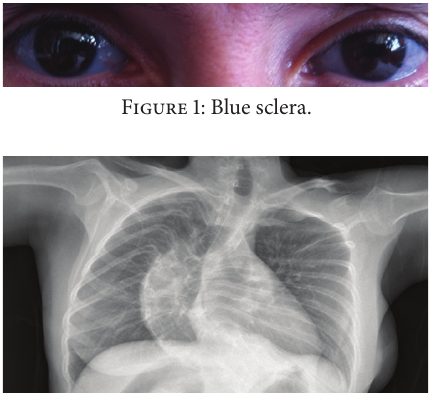
Figure 2: Widened mediastinum with severe scoliosis.